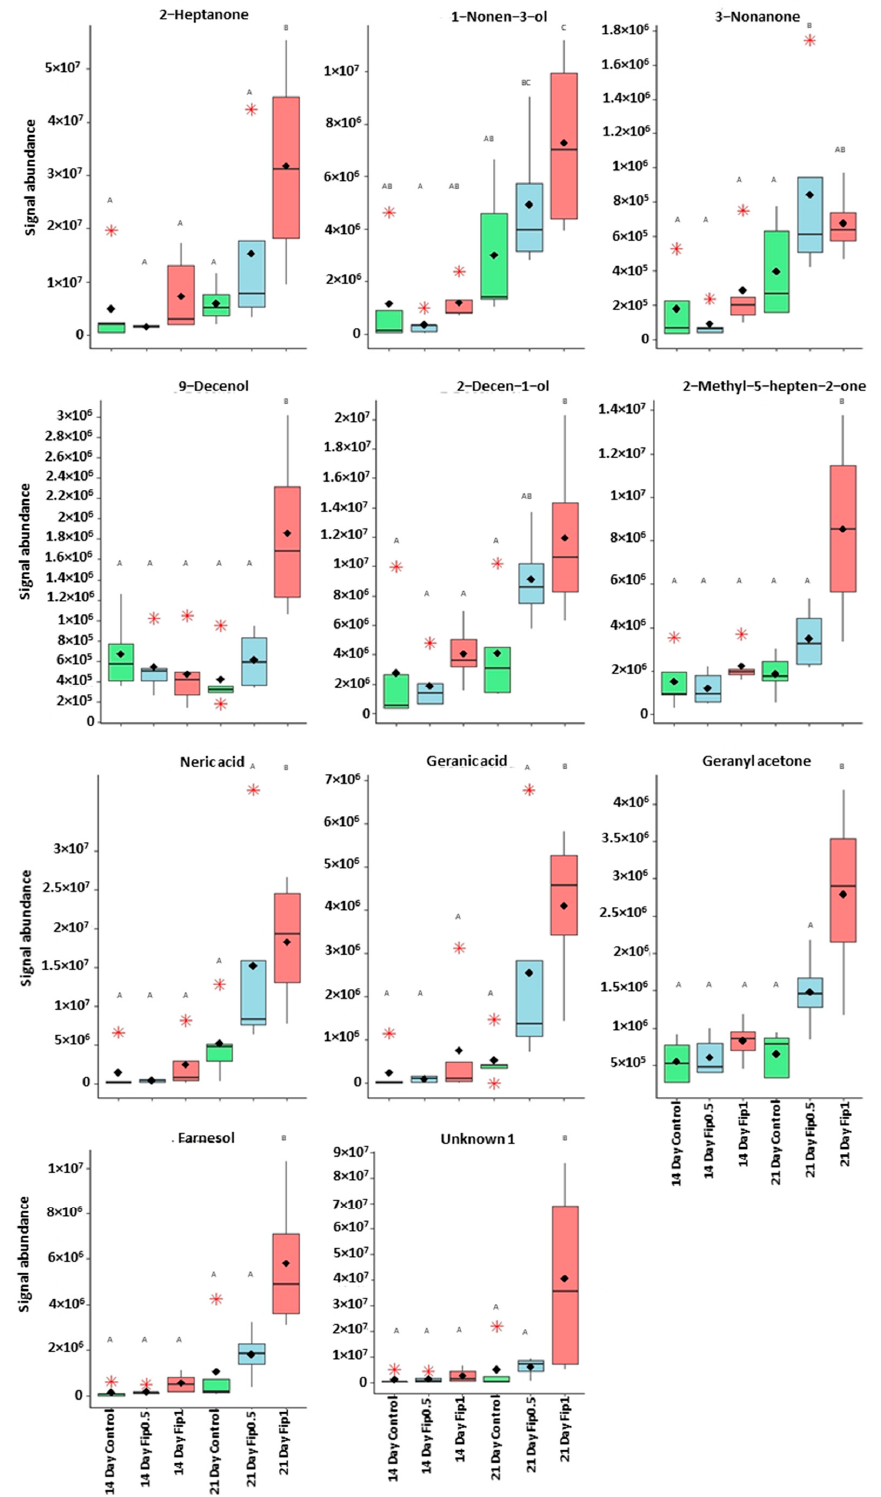
Figure 6. Boxplots representing discriminant compounds whose signal abundance increased with fipronil concentration. Black diamonds represent the average signal abundance of each group. The black horizontal crossbars represent the medians. Red asterisks represent outlier values. Differences in signal abundance are represented by letters. When 2 conditions are characterized by the same letter, there is no significant difference between them ( p -value > 0.05, according to a Newman–Keuls